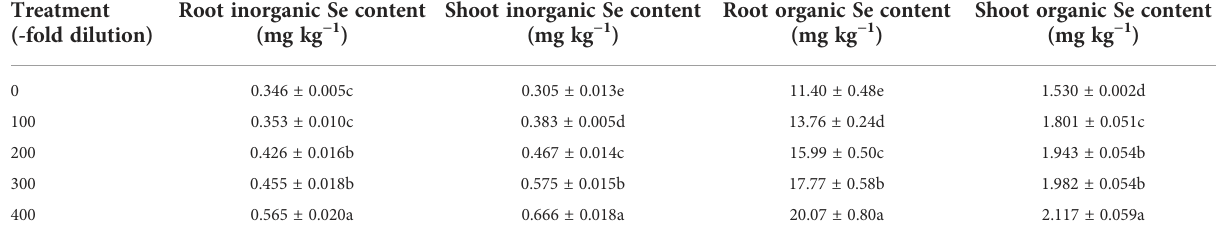
TABLE 1 Inorganic Se and organic Se contents in peach seedlings. Treatment Root inorganic Se content (-fold dilution) (mg kg − 1 )